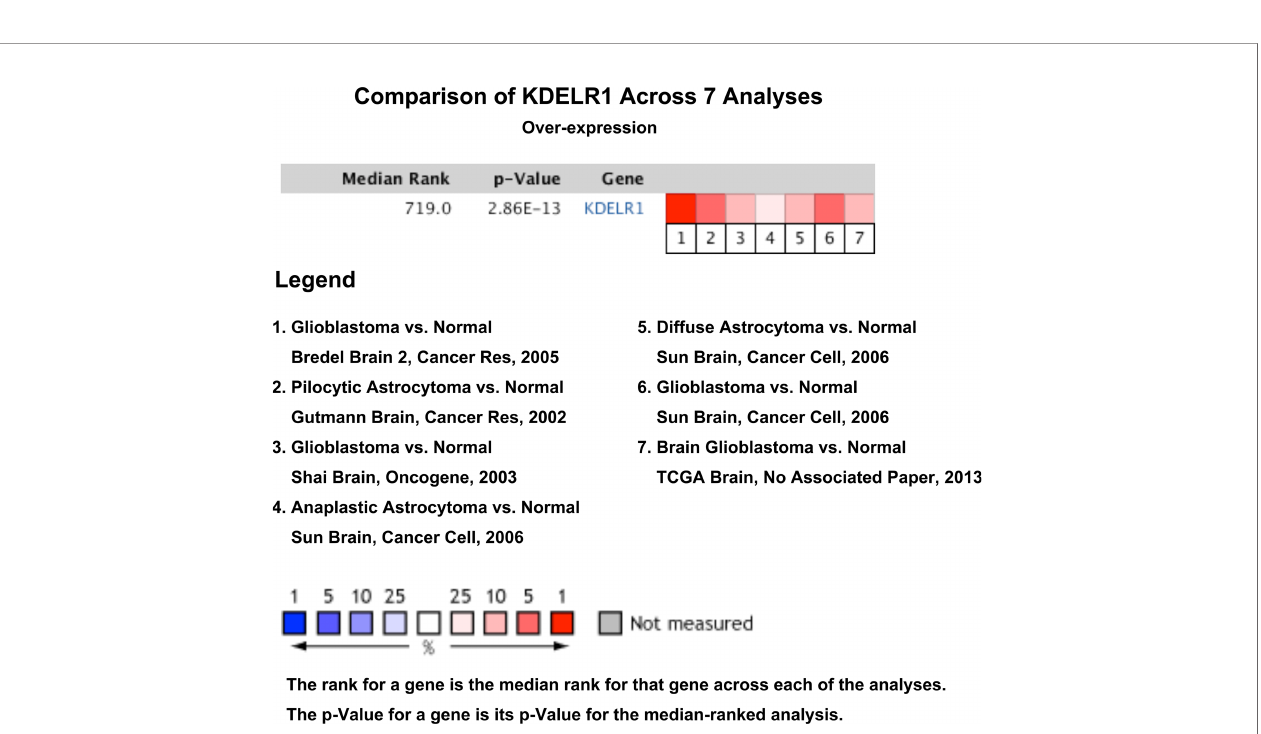
FIGURE 2 | The expression levels of KDELR1 between brain or CNS cancer and corresponding normal samples with the criterion of P < 0.01, fold-change (FC) > 1.5 and gene rank = all using the database Oncomine.